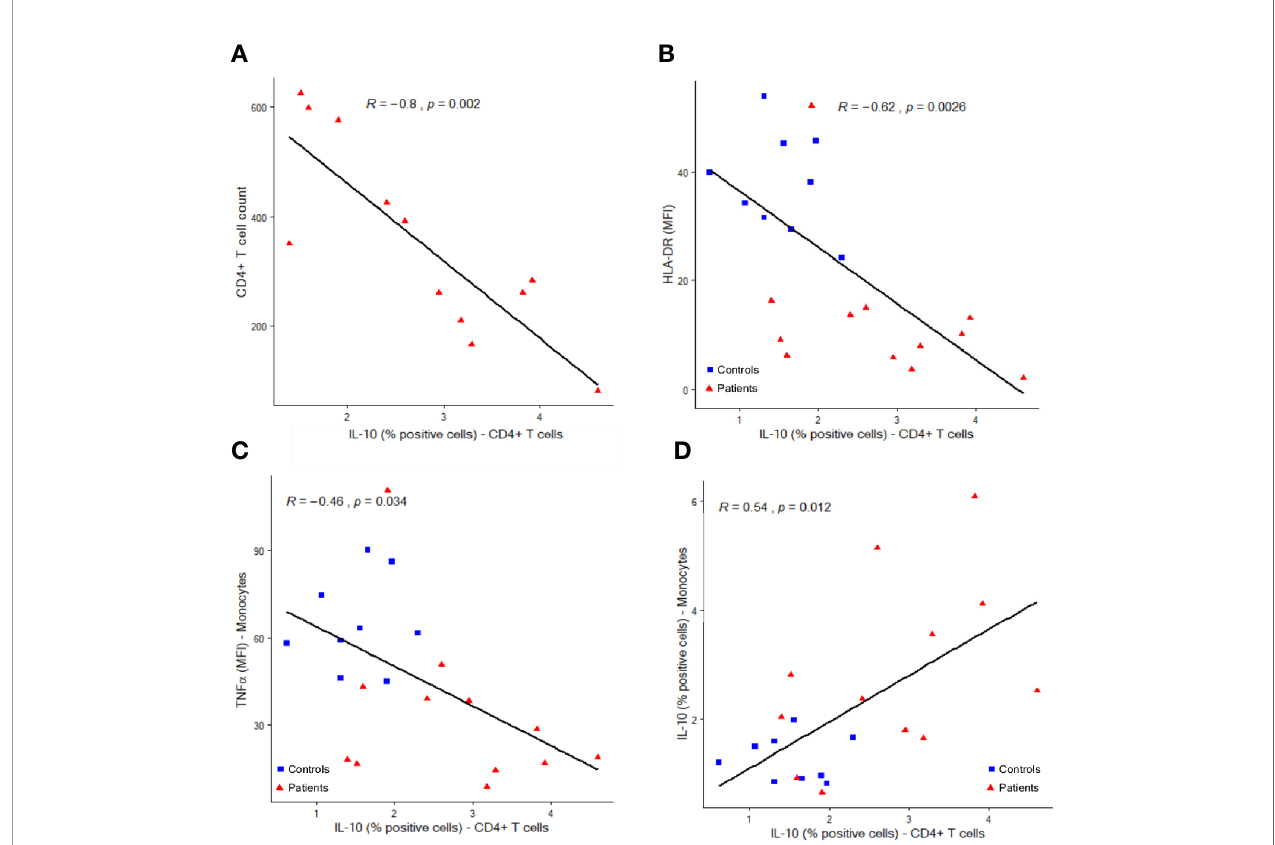
FIGURE 5 | Correlations between IL-10 expressing CD4+ T lymphocytes and other immune parameters. Correlations between IL-10 producing CD4+ T cells (percentages among total CD4+ T cells, x-axis) and CD4+ cell counts ( A , cells per µl, y-axis), monocyte HLA-DR expression ( B , mean fl uorescence intensity = MFI, y-axis), monocyte intracellular TNF a expression ( C , MFI, y-axis) and monocyte intracellular IL-10 expression ( D , percentages of positive cells among total monocytes, y-axis). Correlations were analyzed using Spearman correlation coef fi cient. Results from n = 9 controls (blue squares) and 12 patients (red triangles) are